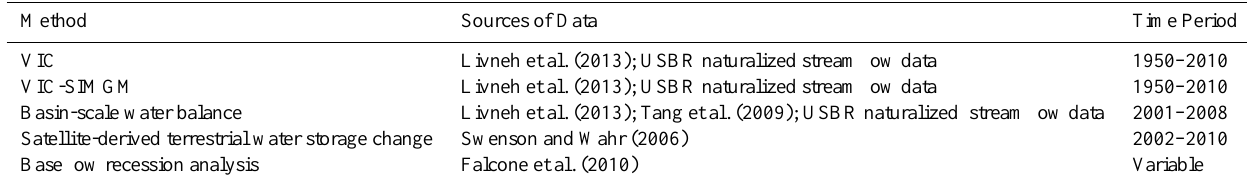
Table 2. Summary of storage computation